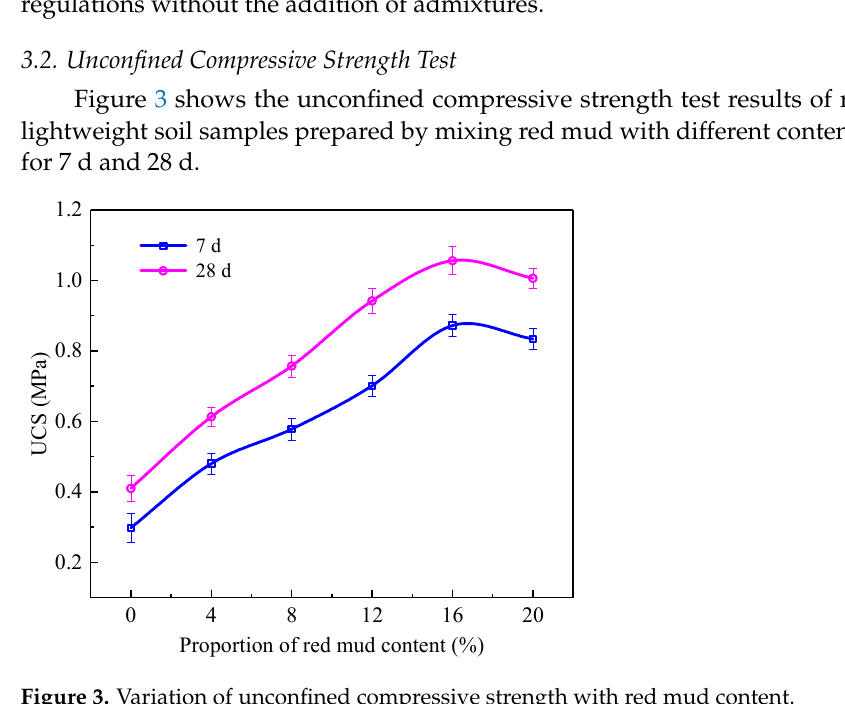
Figure 3. Variation of unconfined compressive strength with red mud content. In the range of 0~16% red mud content, the unconfined compressive strength at 7 d and 28 d greatly increased with the increase in red mud content, and reached the maximum value of 0.872 MPa and 1.056 MPa, respectively, when the red mud content was 16%. With B40R0 without red mud, its unconfined compressive strength at 7 d and 28 d was 0.298 MPa and 0.410 MPa, respectively. In the group B24R16 with 16% red mud content, its 7 d and